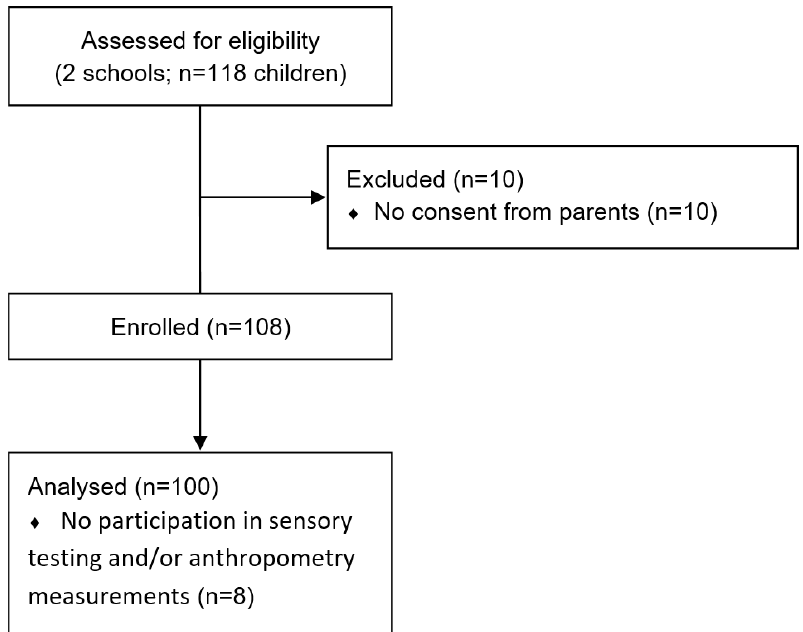
Figure 1. Flow chart of participant recruitment.